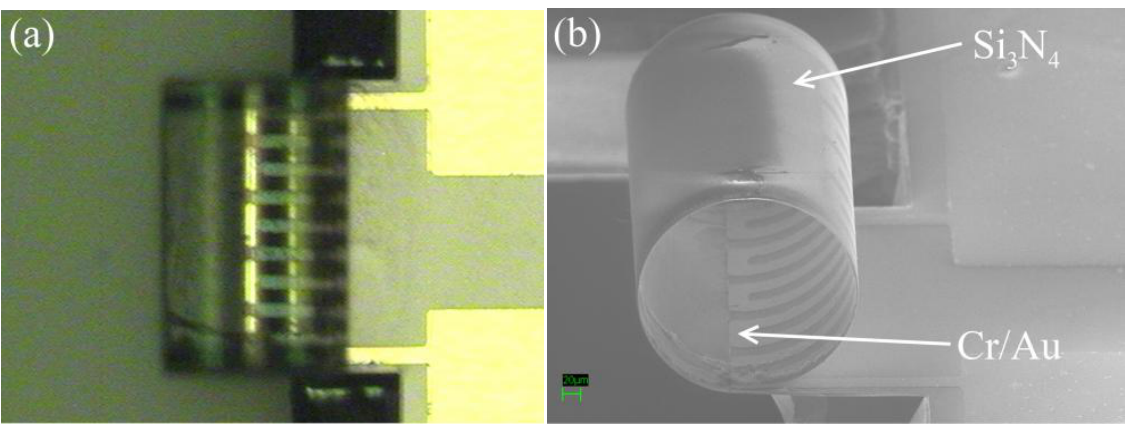
Figure 4. ( a ) Optical micrograph of an out-of-plane (curled) 420 µm × 800 µm cantilever- type Pirani gauge. ( b ) SEM image of the same type of